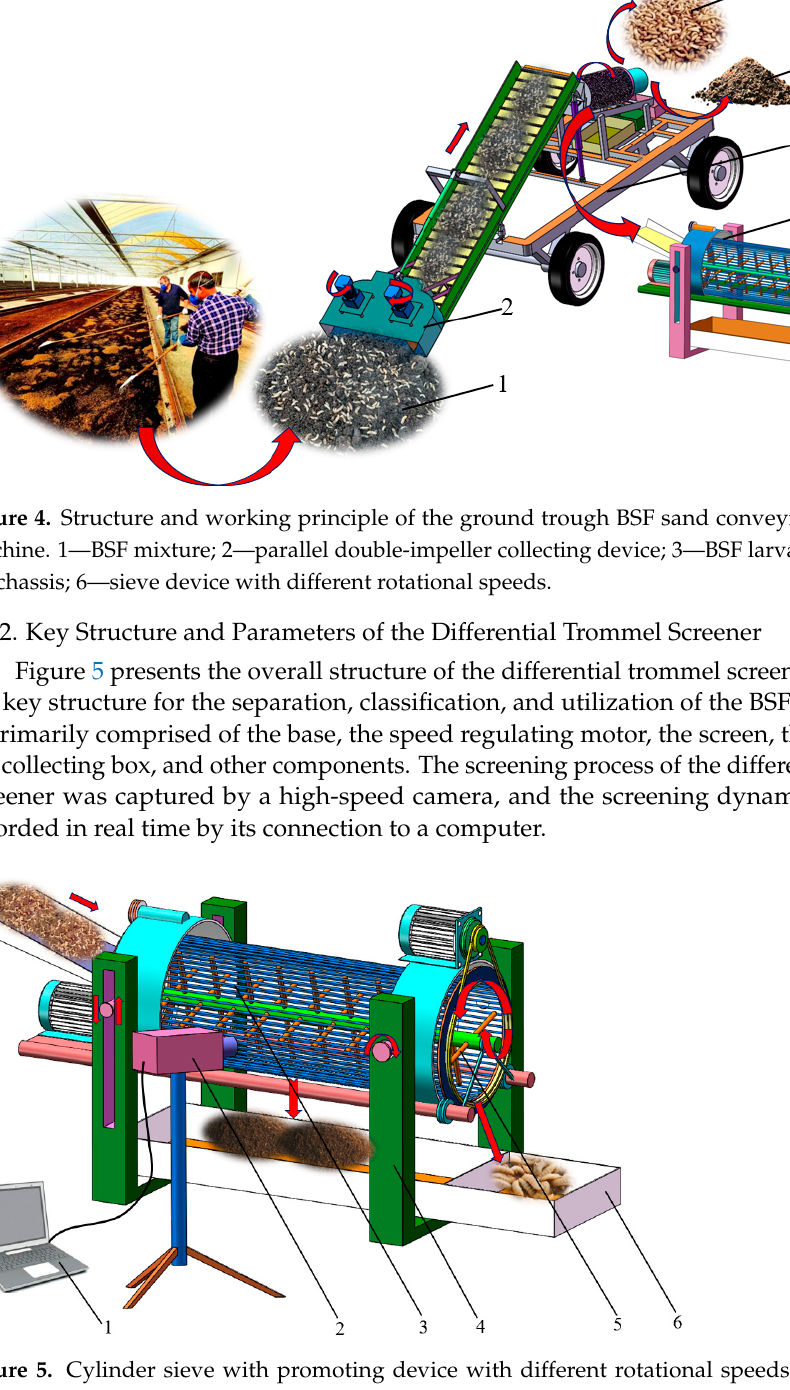
Figure 5. Cylinder sieve with promoting device with different rotational speeds. 1—computer; 2—high-speed camera; 3—tubular screen surface; 4—base; 5—spike teeth; 6—collection box.